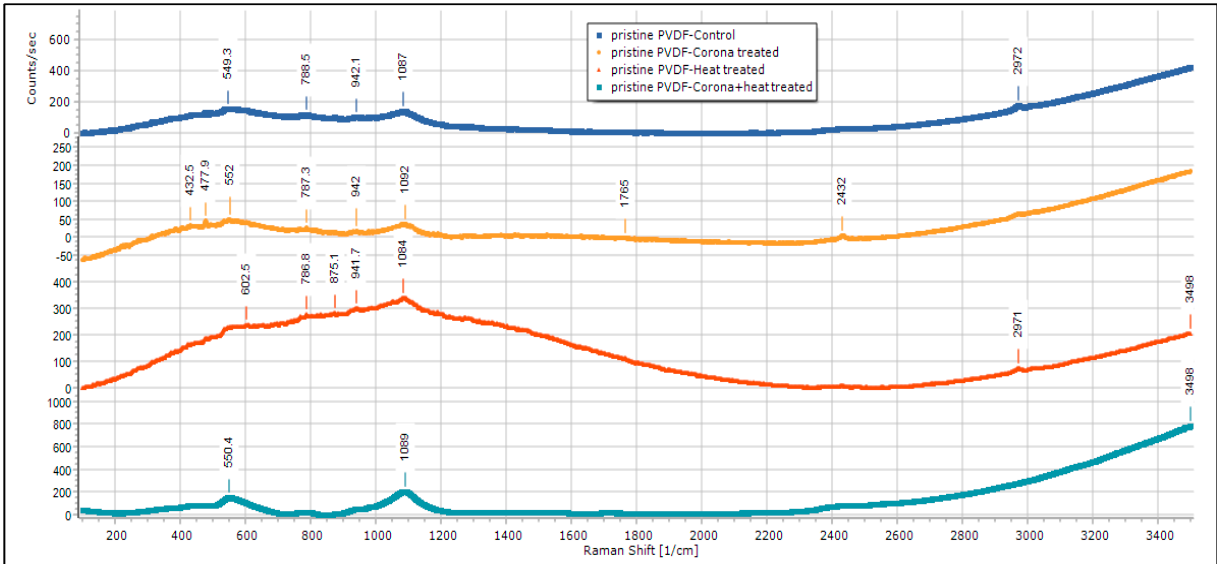
Figure 14. Raman results for pristine PVDF membrane .